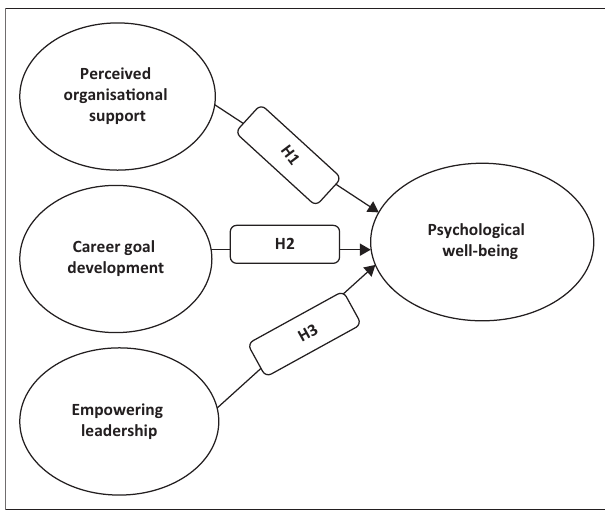
FIGURE 1: Conceptual